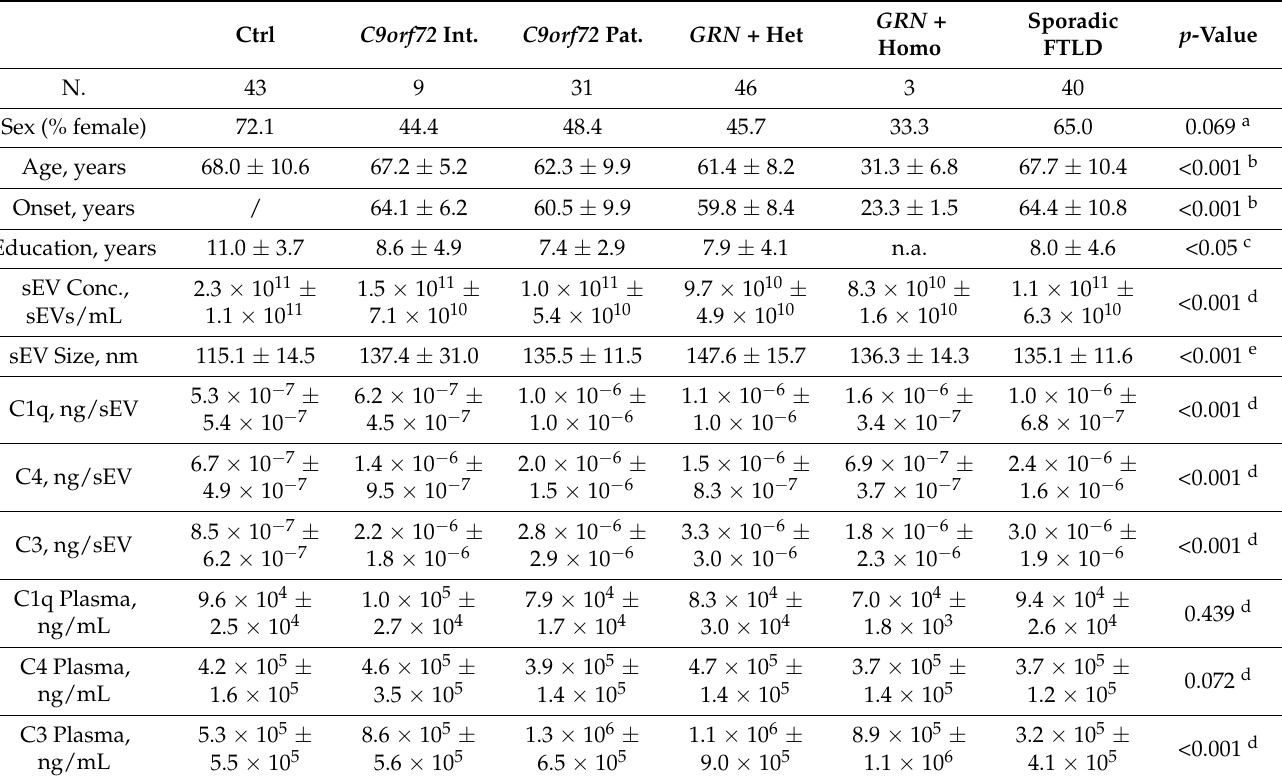
Table 1. Clinical, demographic, and biological characteristics of patients and controls included in the